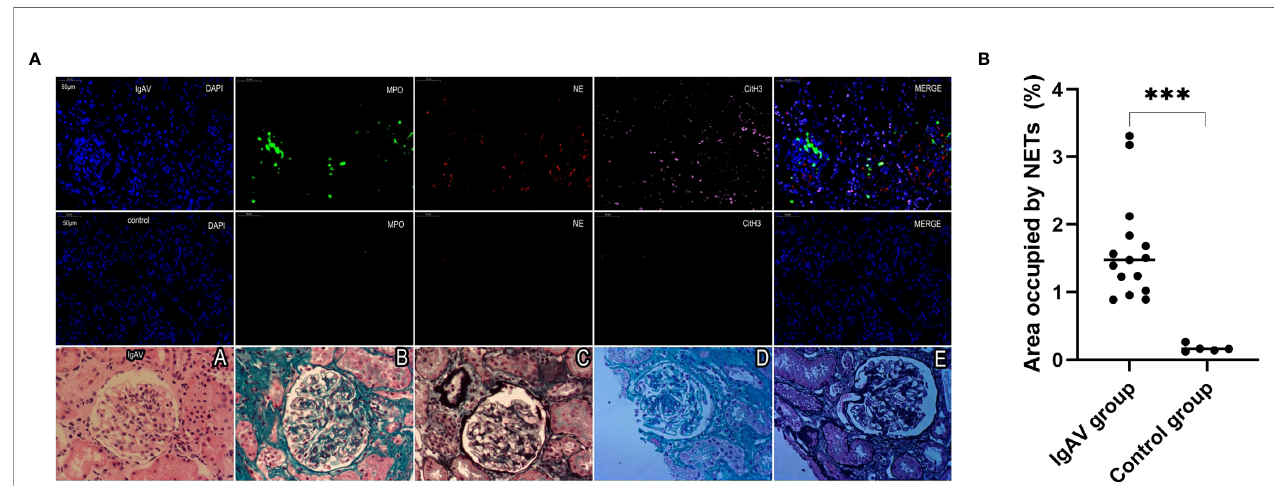
FIGURE 4 | (A) Staining of renal tissue in order to visualize NETs and immuno-histochemical staining. Formalin- fi xed, paraf fi n-embedded sections of renal tissue were subjected to immuno fl uorescence staining for MPO (green), NE (red), and cit-H3 (pink). DAPI was used for DNA staining and is shown in blue. NETs were observed in a pediatric IgAV patient but absent in control tissues. The sections were labeled for extracellular DNA, and cit-H3 was seen to co-localize with MPO/NE in the mesangial area of the glomeruli. Renal pathological types of IgAV were showed focal proliferative glomerulonephritis (A – E) and moderate mesangial hyperplasia glomerulonephritis (D, E). The micrographs are from representative IgAV patients and control. (B) Area occupied by NETs in renal tissue, as determined by image analysis. ***P < 0.01.